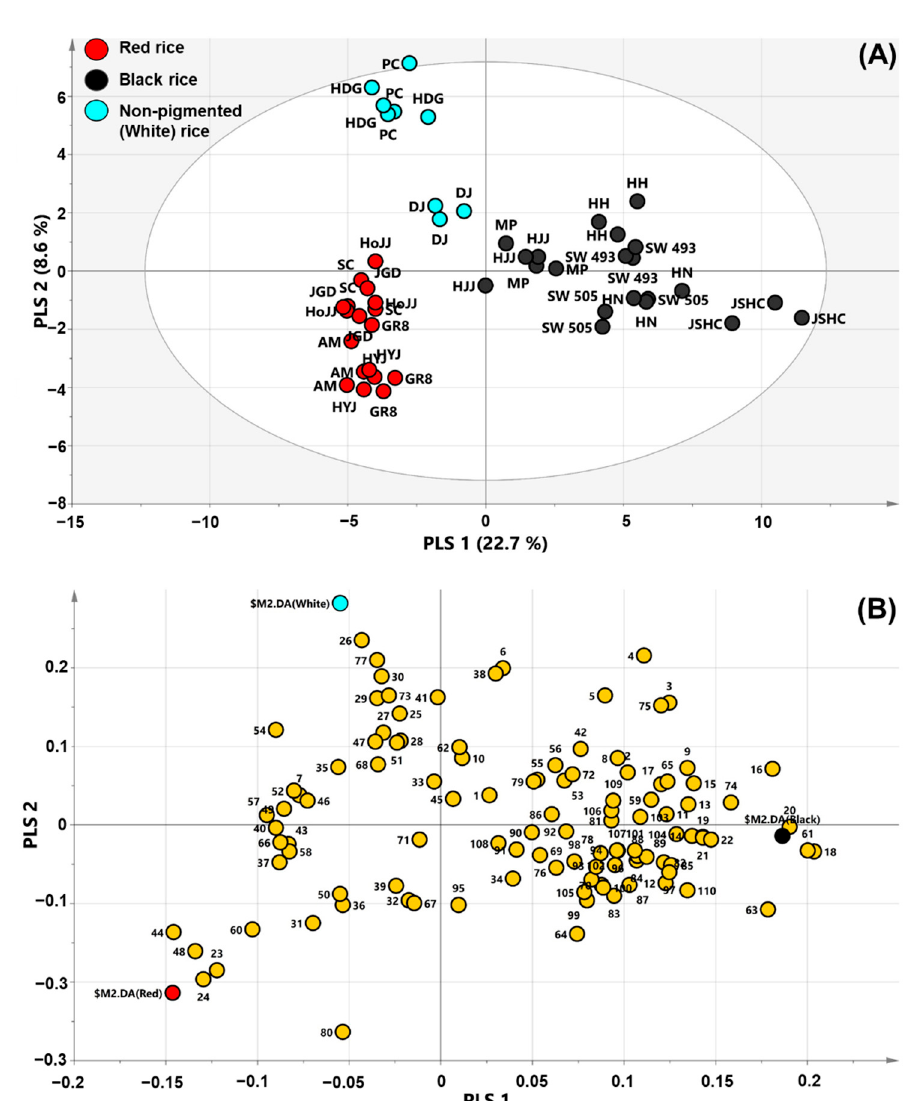
Figure 1. Partial least squares-discriminant analysis (PLS-DA) score ( A ) and loading plots ( B ) derived from 110 metabolites of black, red, and non-pigmented (white) rice cultivars. The ellipse represents the Hotelling T2 with 95% confidence in the score plot. Plot annotation 1, C20-ol (Eicosanol); 2, C21-ol (Heneicosanol); 3, C22-ol (Docosanol); 4, C24-ol (Tetracosanol); 5, C26-ol (Hexacosanol); 6, β -Tocopherol; 7, γ -Tocopherol; 8, C27-ol (Heptacosanol); 9, C28-ol (Octacosanol); 10, γ -Tocotrienol;